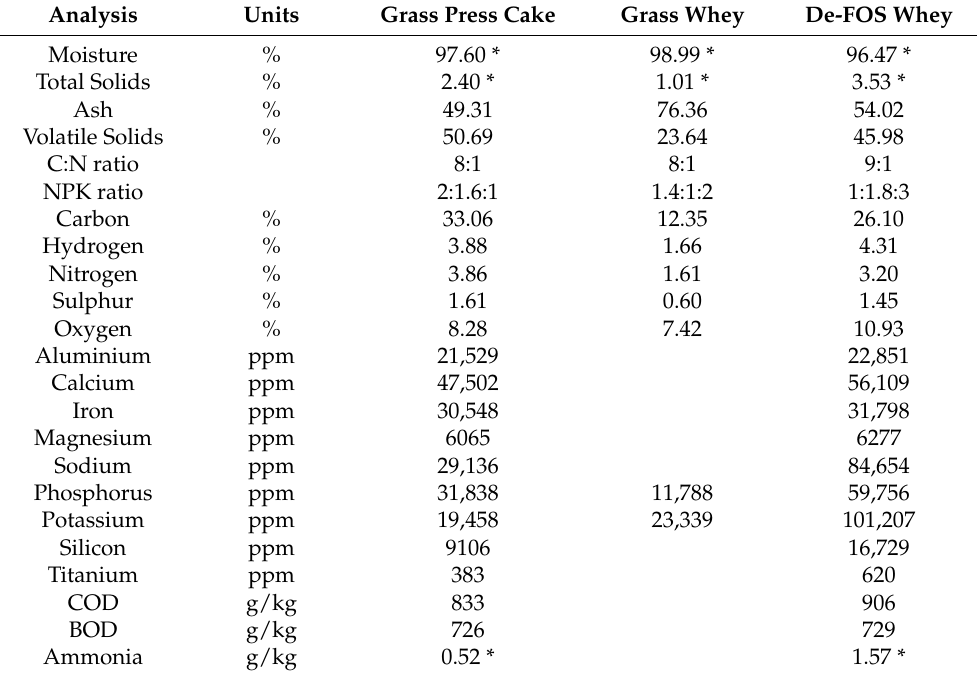
Table 4. Digestate analysis for biorefinery